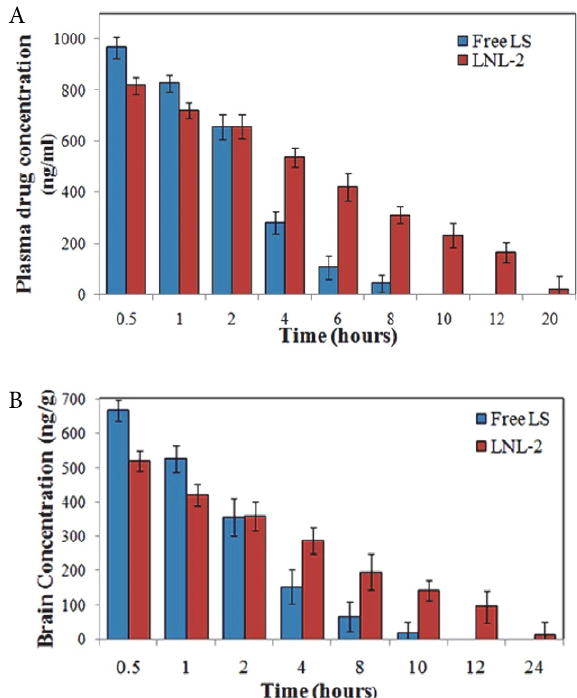
red blood cells (RBCs) treated with lomustine loaded lipid nanos-